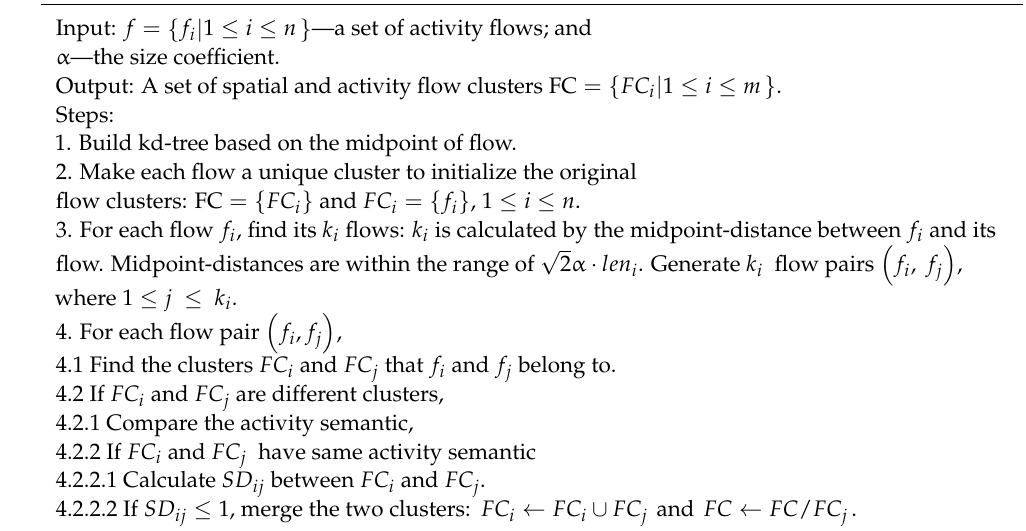
Algorithm 1 Spatial Clustering of Activity Semantic